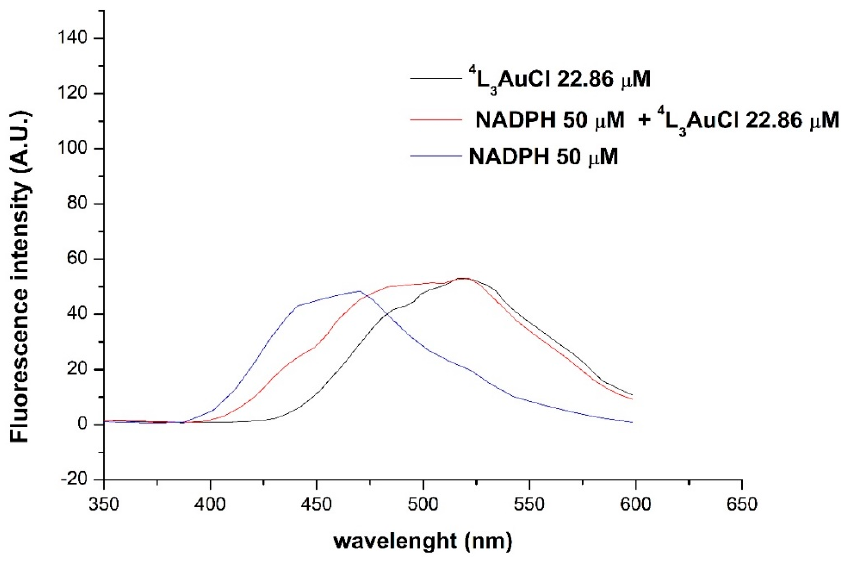
Figure 10. Comparison of the emission spectra recorded for NADPH 50 µ M (blue line), 4 L 3 AuCl 22.86 µ M (black line), and the mixture of them (red line).